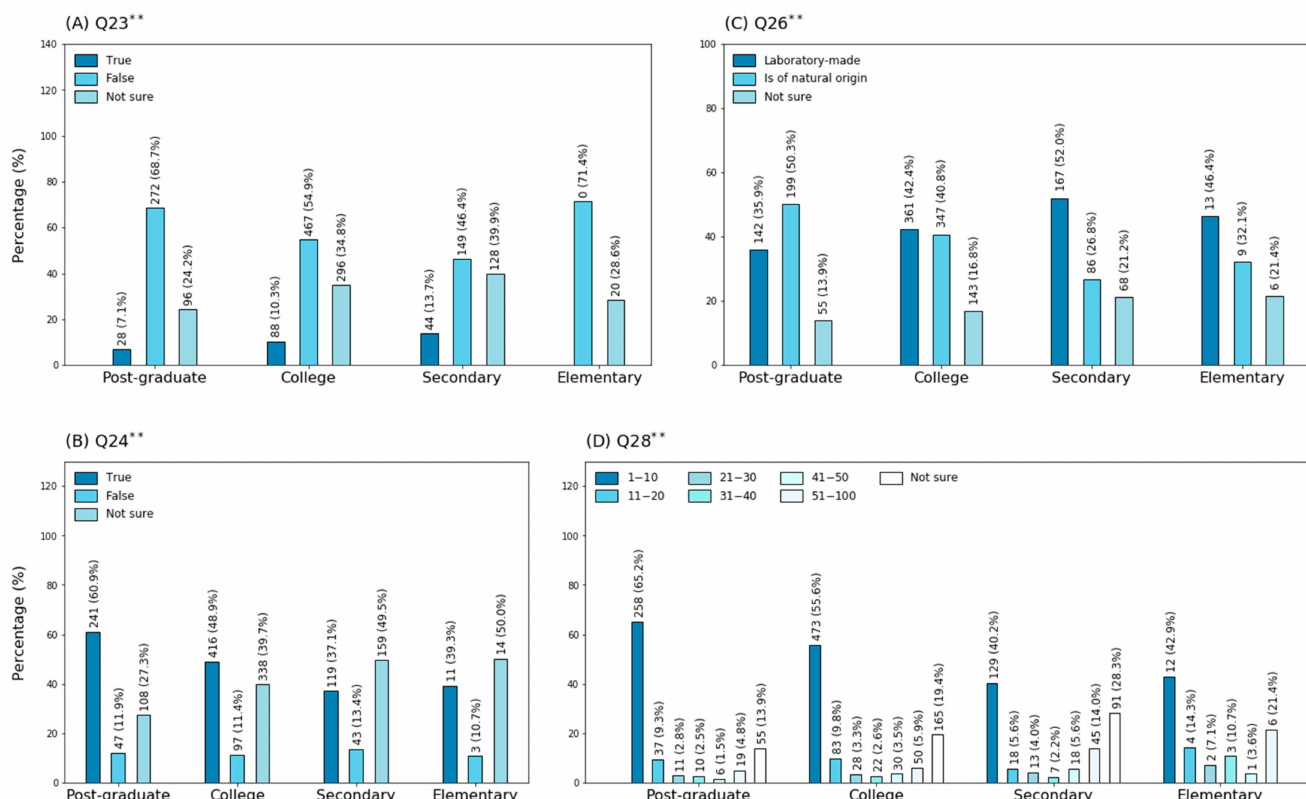
Figure 3. Comparison of response percentages among educational group: ( A ) Question 23; ( B ) Question 24; ( C ) Question 26; ( D ) Question 28. ** Chi-square values significant at p <